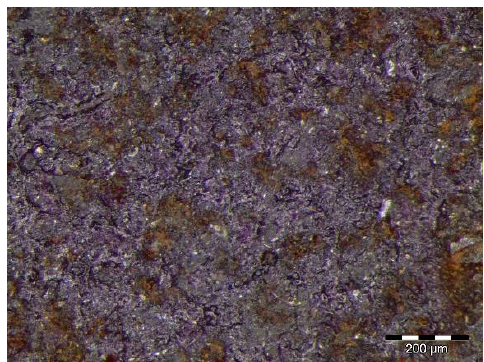
Figure 10. Surface estate of the C1 coating after 1440 h of exposure to neutral salt spray showing a high density of ferric corrosion pits along the whole exposed surface. In the case of the C2 coating, the presence of white salts was detected after 672 h in the chamber. These salts were observed in the form of small deposits, which increased in size with exposure